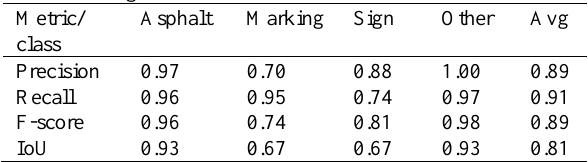
Table 1. Class-wise and average metrics of point cloud segmentation.